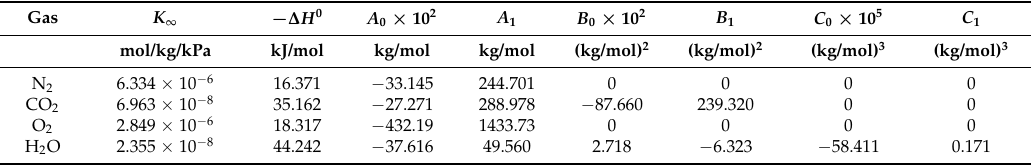
Table A1. Fitting parameters of the Virial model for N 2 , CO 2 , O 2 , H 2 O on the carbon